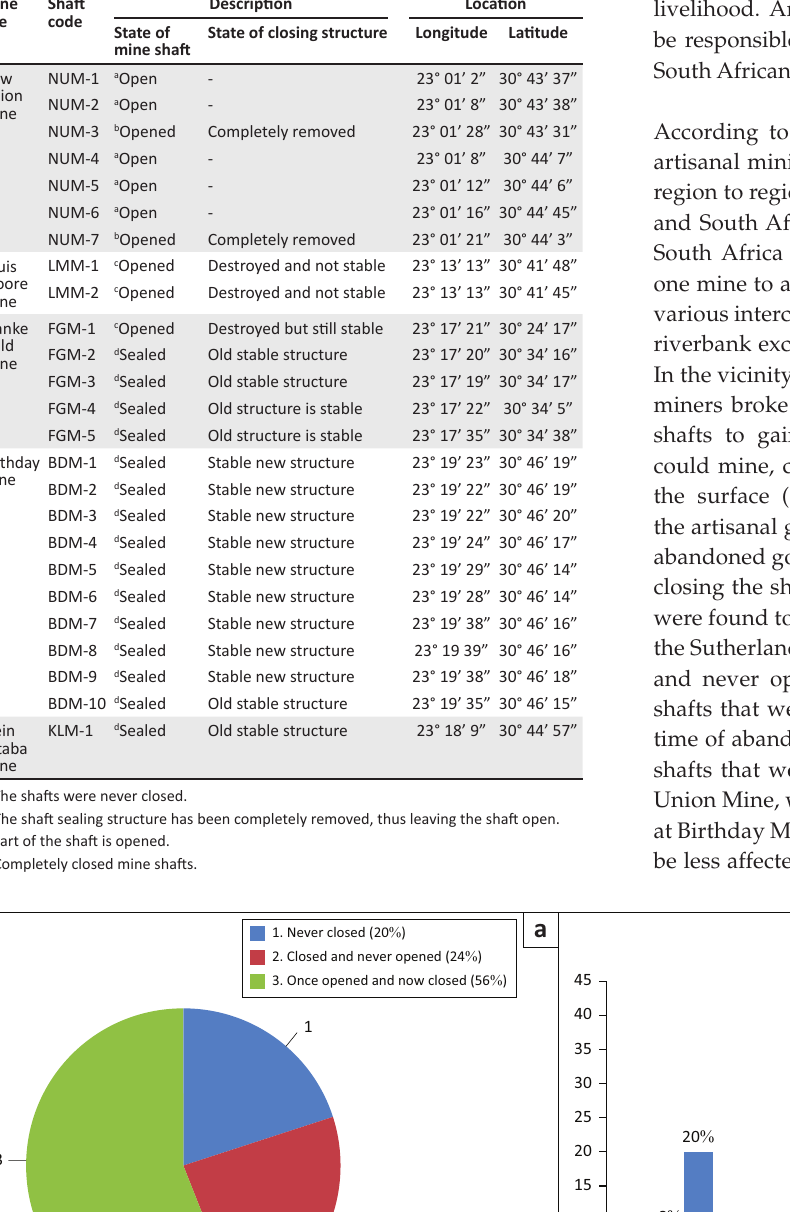
TABLE 1: The current state of the mine shafts at Sutherland goldfield.